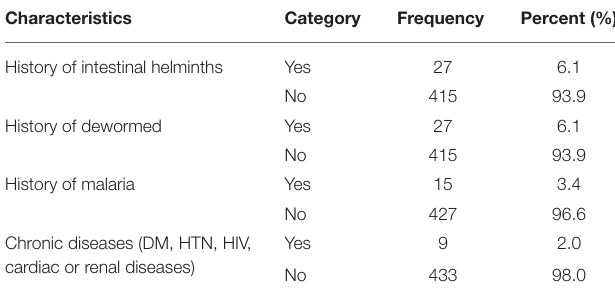
TABLE 5 | Diseases and infection characteristics of respondents attending ANC in a University hospital in Eastern Ethiopia, 2021 ( n = 442). Characteristics